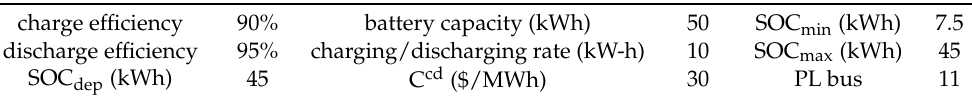
Table 3. Required specifications of